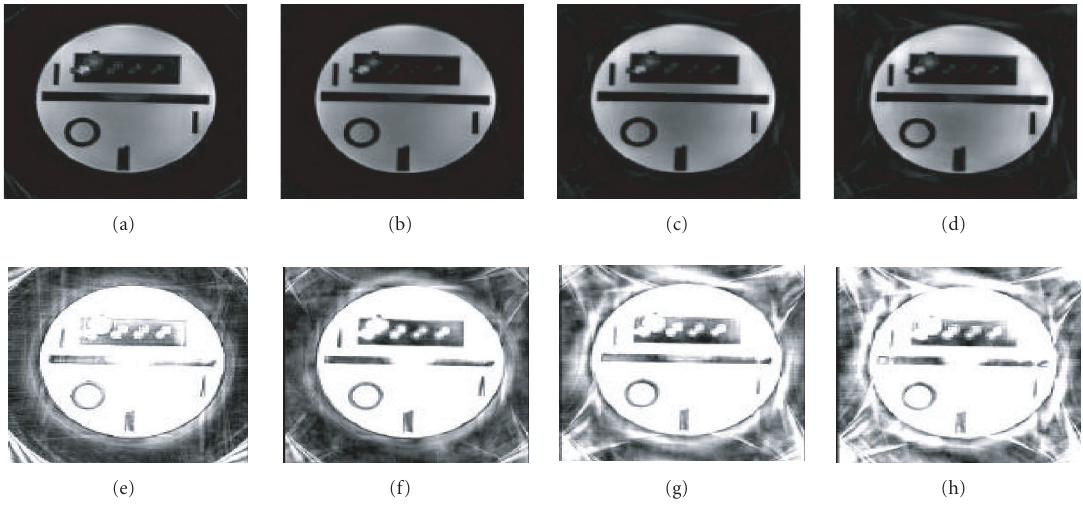
Figure 3: Images reconstructed with (a) conventional gridding (best image with optimized parameters), (b-d) new method with energies 90%, 80%, and 70% of the energy retained, respectively. The lower row shows the same images windowed at 10% of the maximum level for each to better illustrate the residual